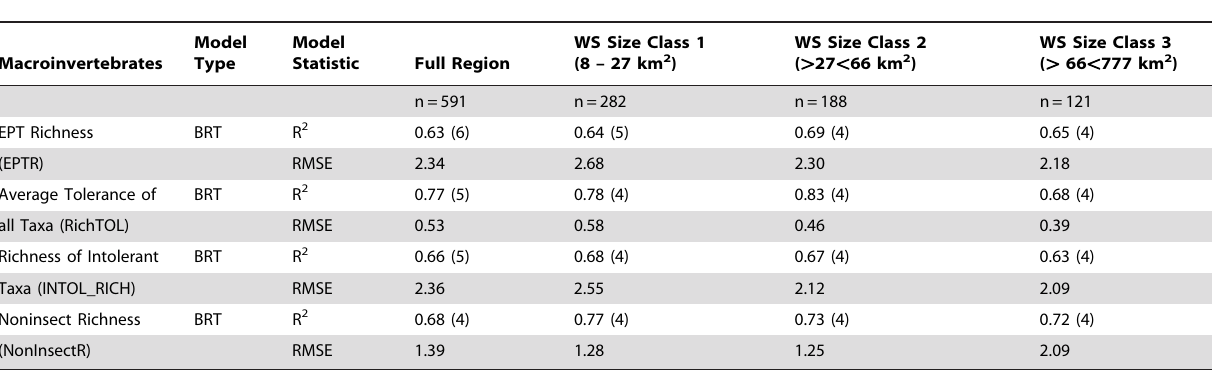
Table 5. Comparison of model evaluation statistics for four macroinvertebrate metrics for three watershed size classes, number of variables in final model in